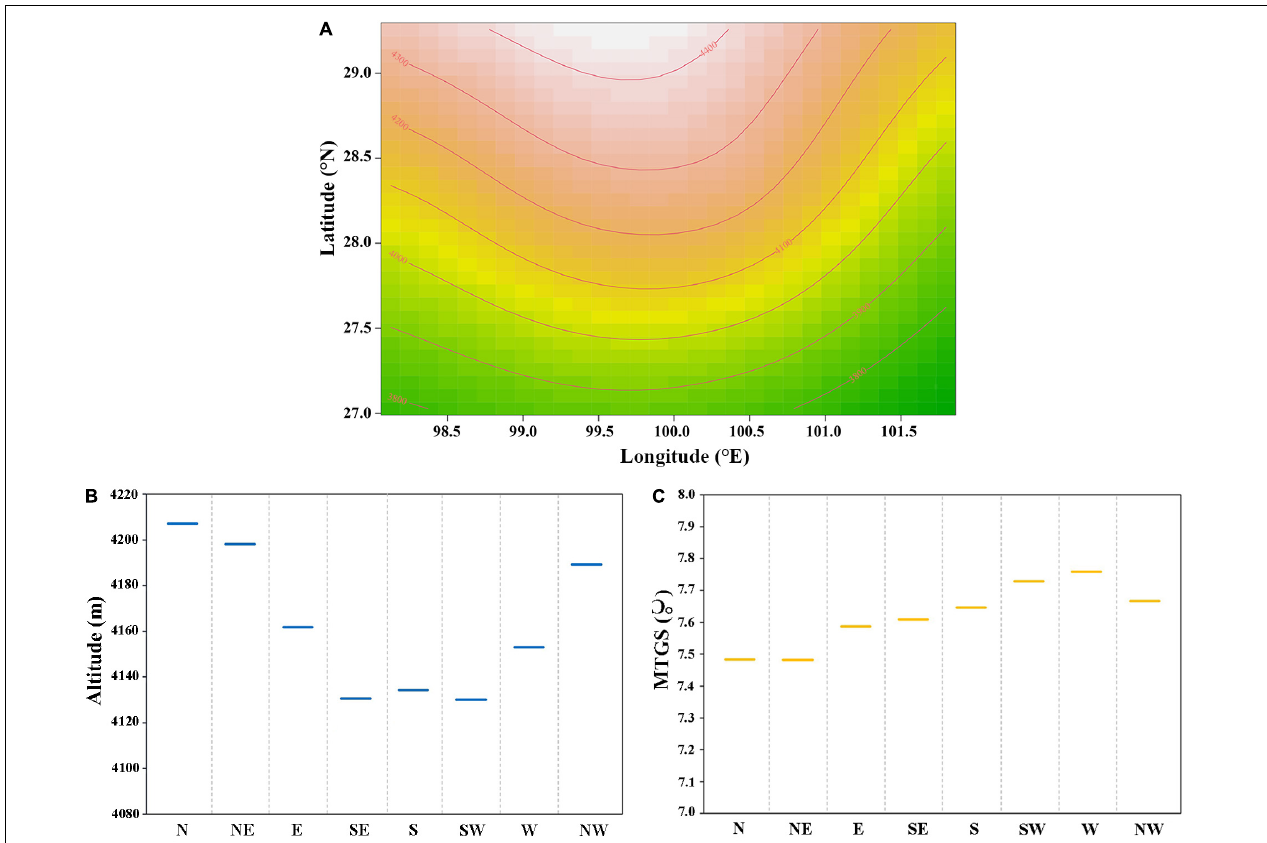
FIGURE 3 | (A) Variation of treeline elevation with longitude and latitude, orange lines represent treeline elevation contours; (B) average elevation of alpine treeline with different slope directions; (C) mean temperature of growing season of alpine treeline with different slope directions.